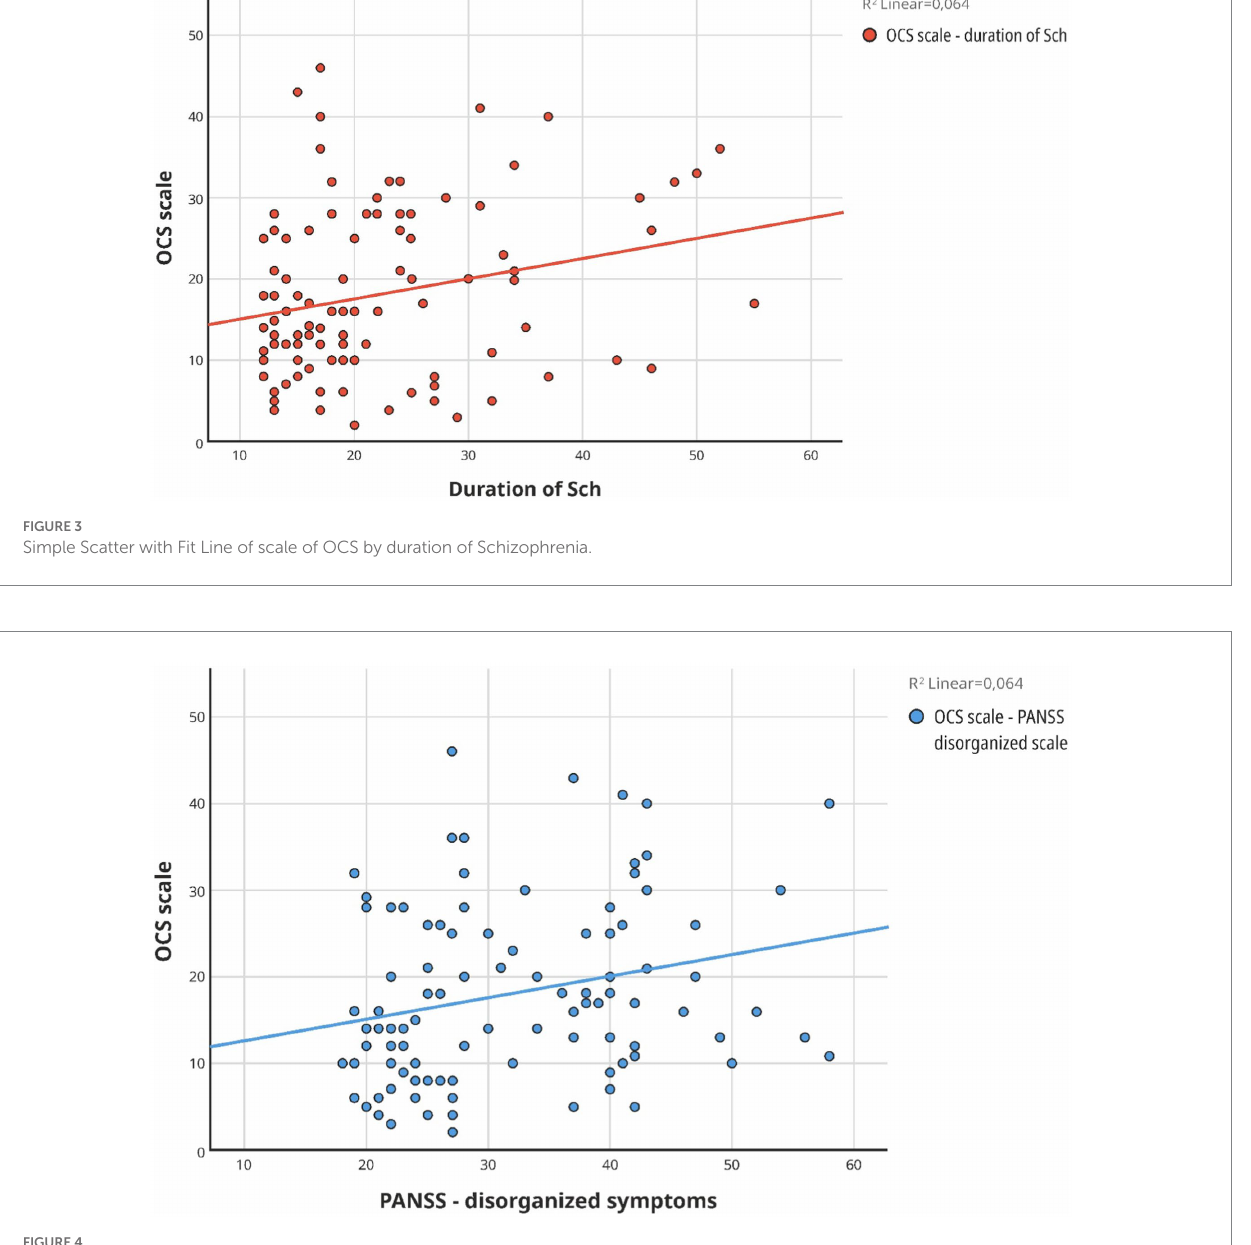
FIGURE 4 Simple Scatter with Fit Line of scale of OCS by PANSS- disorganized symptoms